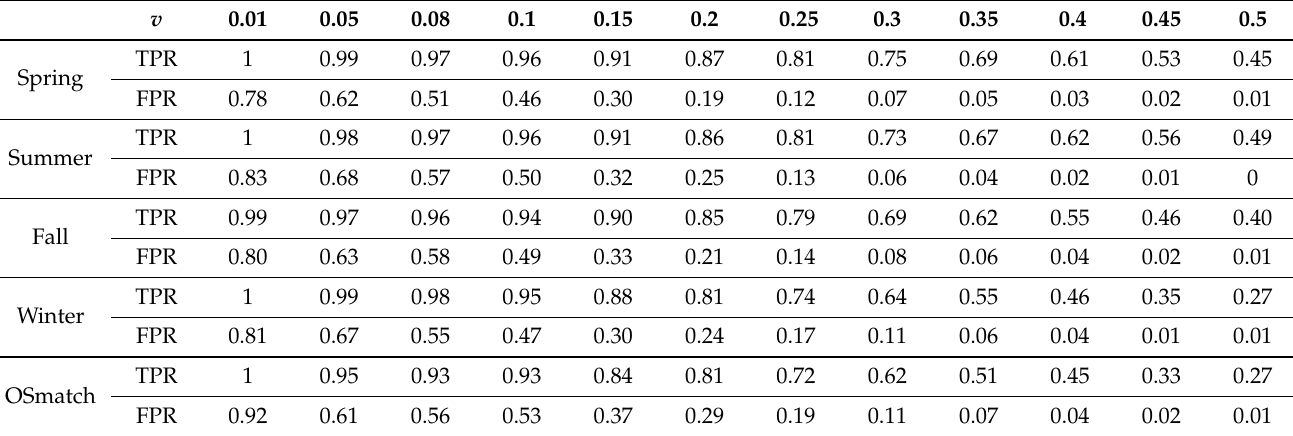
Figure 9. ROC curves deliverd on SEN1-2 dataset. Table 1. TPR and FPR results for One-Class SVM on SEN1-2 and OSmatch